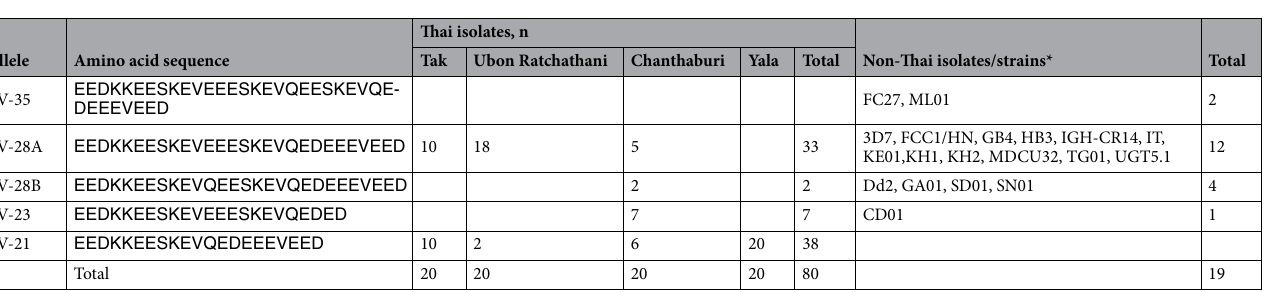
Table 4. Diversity and distribution of repeat alleles in block 9 (repeat domain V) of PfGARP. MDCU32 is from a Guinean patient. *GenBank accession numbers are listed in “Materials and